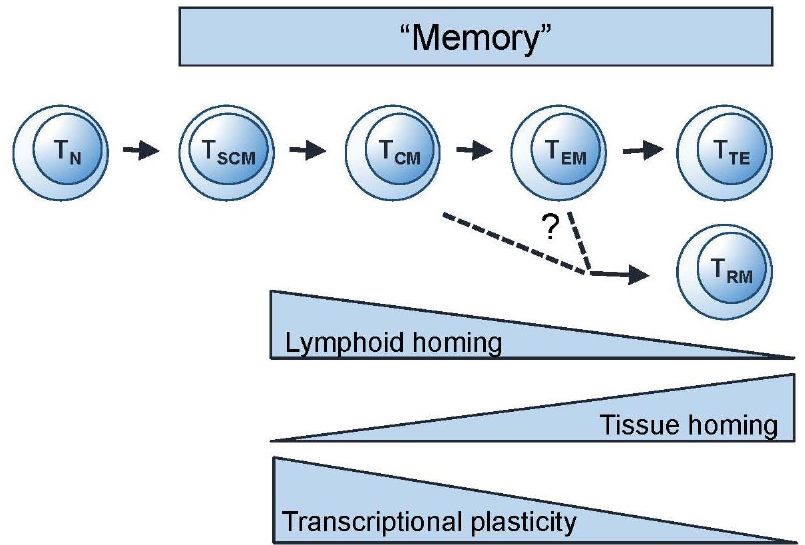
Figure 2. Linear differentiation model for T cells. Model for successive development of stem cell memory (T SCM ), central memory (T CM ), effector memory (T EM ), and terminal effector memory (T TE )